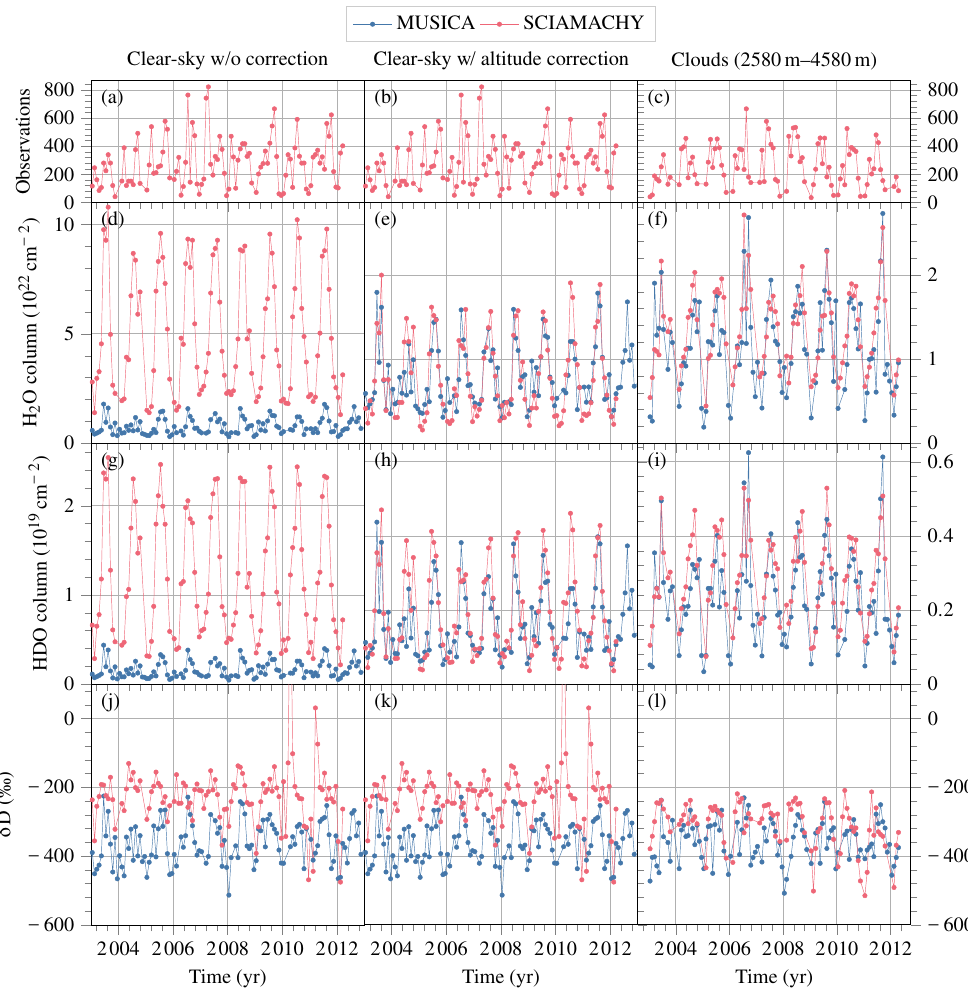
Figure 8. Time series of monthly medians similar to those shown in Fig. 3 but for scattering retrievals near the high-altitude station Jungfrau- joch (3580ma.s.l.). The left panels (a) , (d) , (g) and (j) show clear-sky measurements without altitude correction; the centre panels (b) , (e) , (h) and (k) show the same measurements with altitude correction; and the right panels (c) , (f) , (i) and (l) show observations with optically thick clouds within an altitude range 1000m above and below the station height. Please note that in the left panels the H 2 O and HDO axes are different than in the centre and right panels, as indicated by the axis